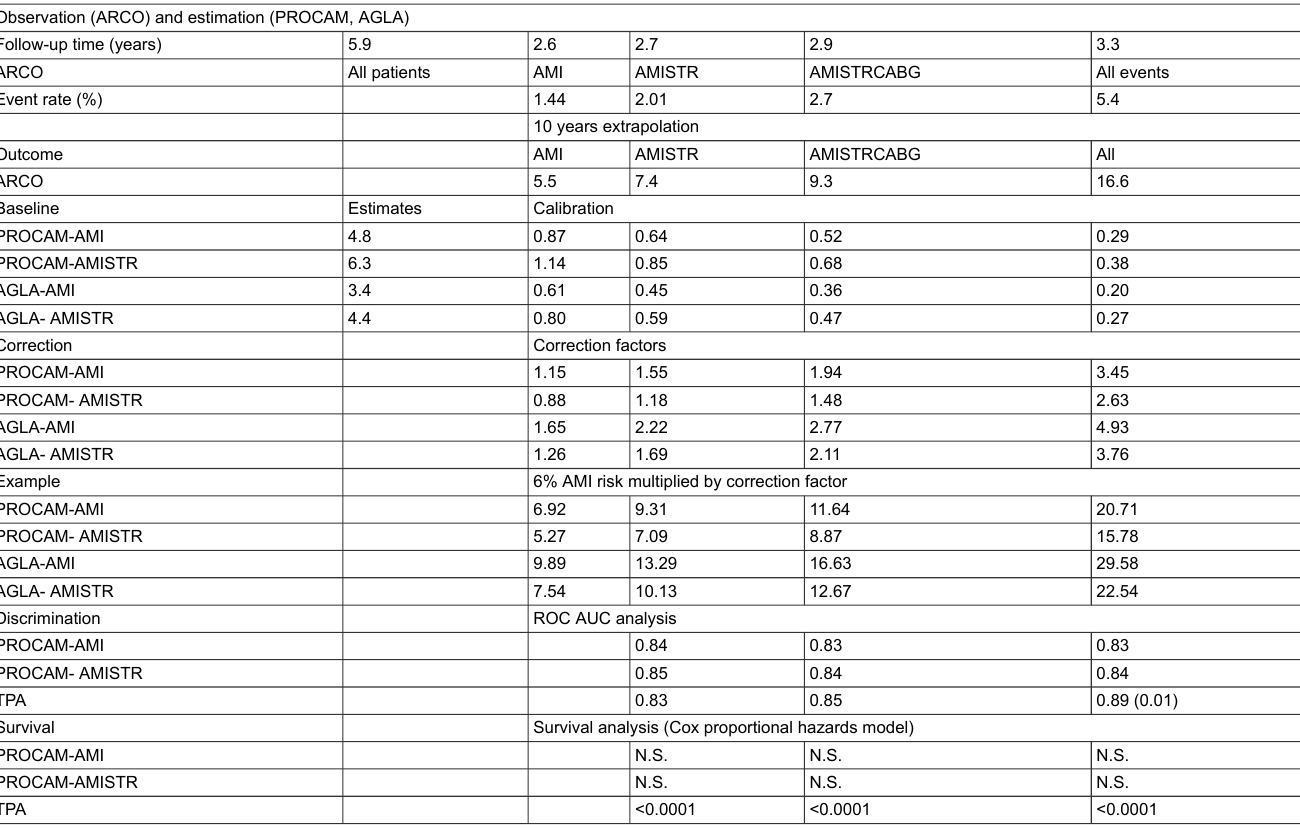
Table 2: Calibration factors and performance of PROCAM and AGLA to detect events from the ARCO cohort with event rates extrapolated to 10 years for various outcomes separately (AMI, AMI + STR, AMI + STR + CABG, All). Observation (ARCO) and estimation (PROCAM,